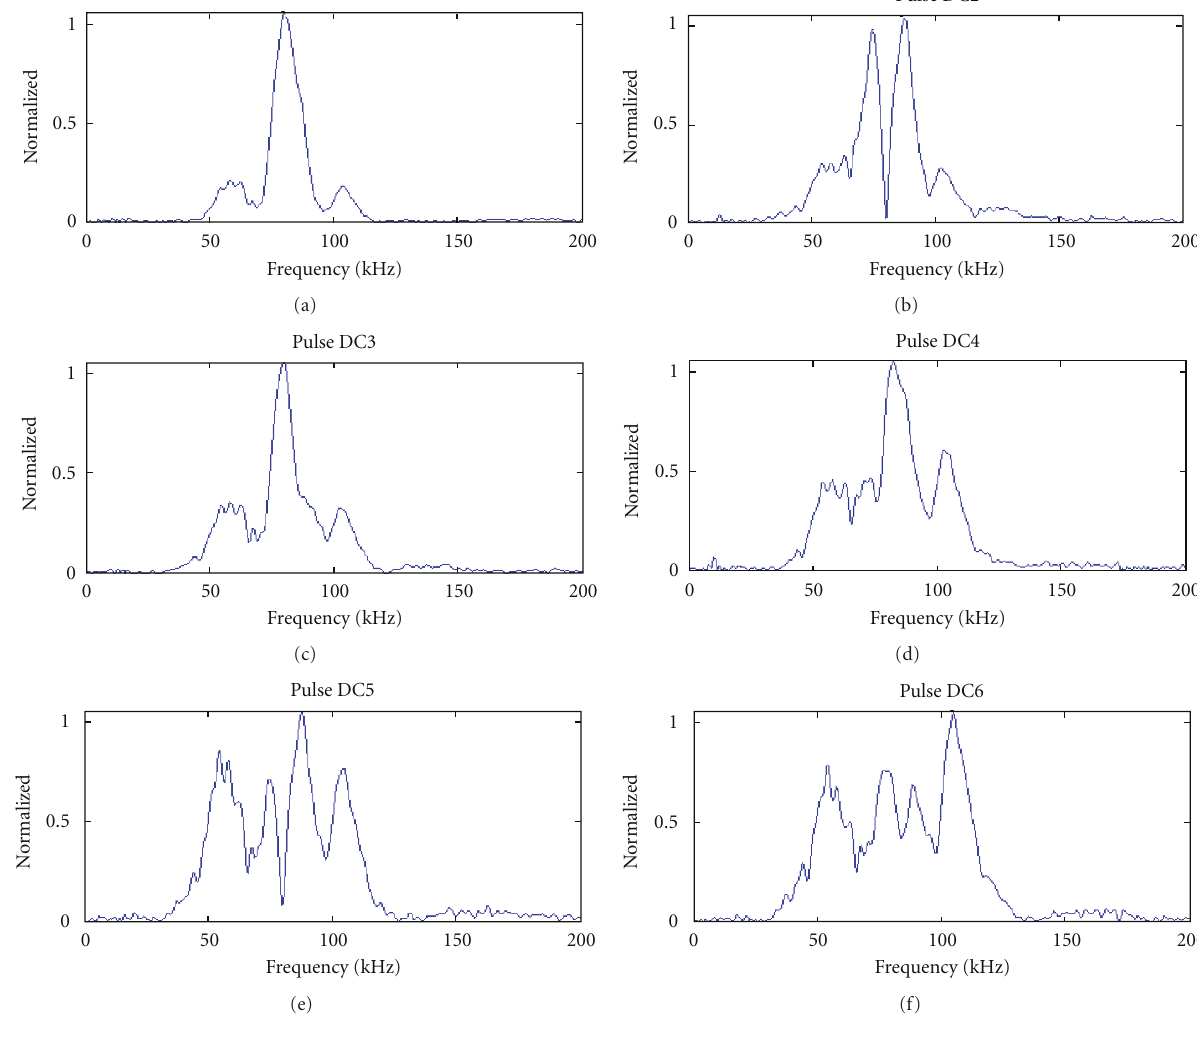
Figure 22: Spectral responses for cable type B, pulses